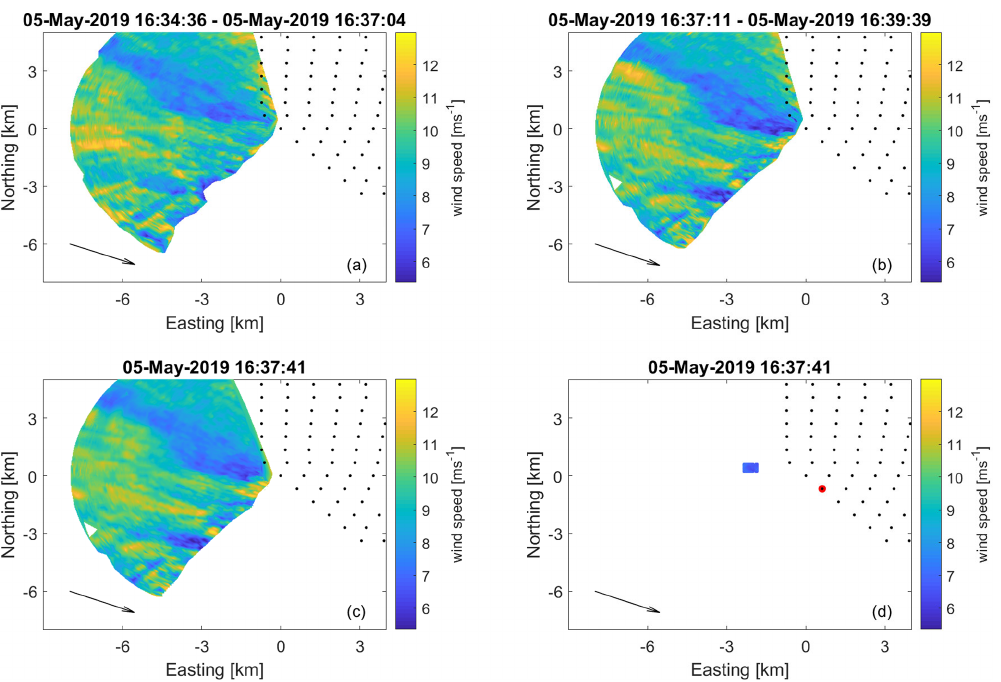
Figure 3. Time synchronization and wind speed forecast of an exemplary scan. Panels (a) and (b) depict two consecutive lidar scans at GTI with black dots indicating the positions of the turbines. In (c) the time-synchronized scan, determined as a combination of the forward- propagated scan (a) and the backwards-propagated scan (b) , is shown. In (d) a point cloud of wind vectors that will reach T3 marked in red after a forecasting horizon of 5min ± 30s is visualized. The mean wind direction of the scan is shown in black.